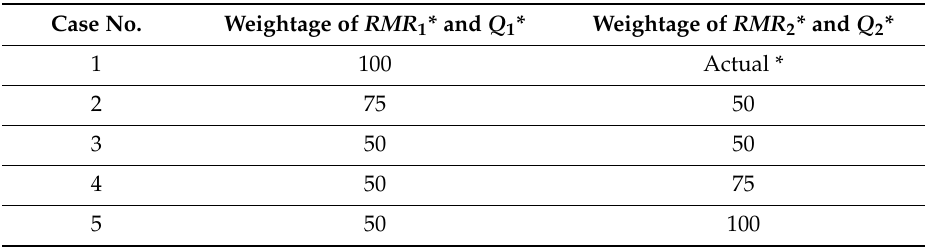
Table 6. Five di ff erent cases for calculating RMR * and Q * (Figure 1) while considering the weightage of the rock-mass quality obtained from rock bolts spacing and shotcrete thickness along with tunnel span. Case No.